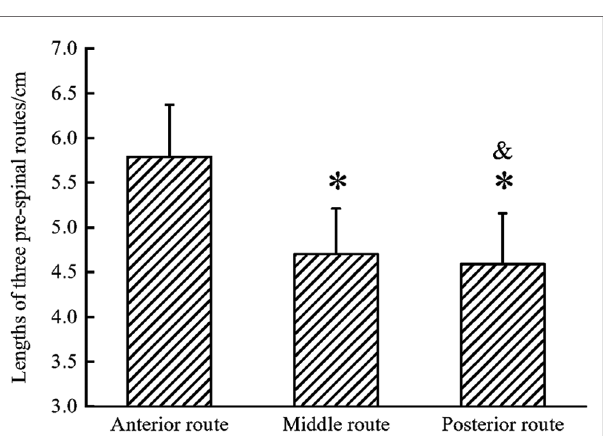
FIGURE 3 | Statistical chart of lengths of three prespinal routes on T1WI. The lengths of the two were statistically shorter than that of the anterior route (the middle, p <0.001; the posterior, p <0.001). No signi fi cant difference was observed between the middle and the posterior route ( p =0.57).